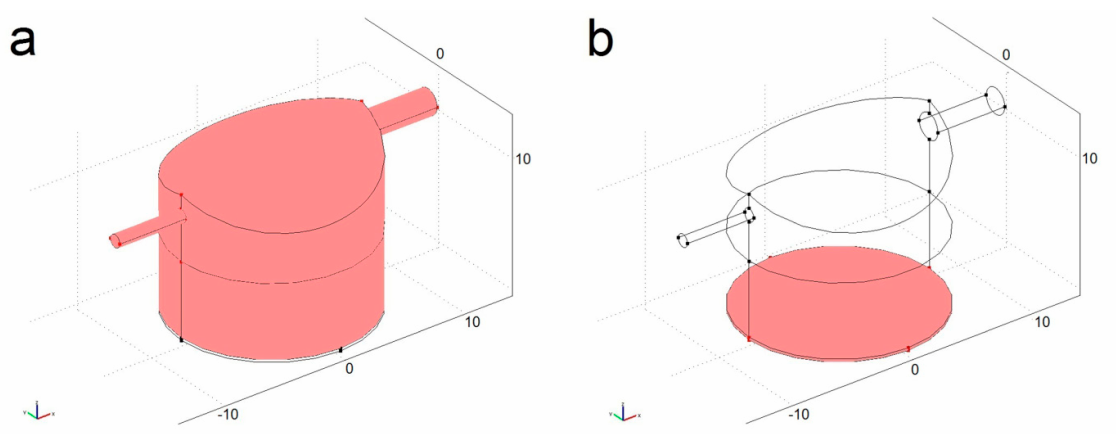
Figure 5. MCmB culture chamber: ( a ) the fluid domain and ( b ) hydrogel construct domain are shaded. All dimensions are in